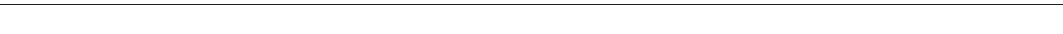
Fig. 6 Overexpression of CDYL in vivo inhibits functional Nav1.6 current. a Double staining for AnkG ( red ) and Nav1.6 ( green ) in cortex and hippocampal DG region of mice. Scale bar , 10 μ m. The axon initial segment showed strong staining for Nav1.6. b Typical spikes ( left ), associated phase plane plots ( middle ), and the average spike threshold ( right ) obtained from DG neurons of WT, TG, and EZH2-shRNA-infected TG mice. * p < 0.05, one-way ANOVA with Bonferroni ’ s multiple-comparison test. c Western blotting showing SCN8A was signi fi cantly reduced after SCN8A-shRNA lentivirus injection into mouse hippocampal DG area for 14 days ( left ), quanti fi cation was done by normalizing the level of SCN8A to that of β -actin (middle, n = 3), and the average spike threshold obtained from DG neurons of shRNA-Control (NC), shRNA-SCN8A#1 and shRNA-SCN8A#2, * p < 0.05, ** p < 0.01, unpaired two- tailed Student ’ s t -test. shRNA-SCN8A#1 was used for the subsequent experiements. d Expression of lentiviruses in 14 days after infecting the mouse hippocampal DG area. Scale bar , 200 μ m. e Typical spikes ( left ), associated phase plane plots ( middle ), and the average spike threshold ( right ) obtained from DG neurons of shRNA-Control, shRNA-CDYL and both shRNA-CDYL and shRNA-SCN8A infected mice. * p < 0.05, one-way ANOVA with Bonferroni ’ s multiple-comparison test. f Typical action potentials and associated phase plane plots obtained from DG neurons of WT and TG mice, in the presence and absence of 75 nM 4,9-TTX. g Graphs showing the average AP threshold before and after adding 4,9-TTX. ** p < 0.01, NS means non- signi fi cant, one-way ANOVA with Bonferroni ’ s multiple-comparison test. Data were represented as mean ±